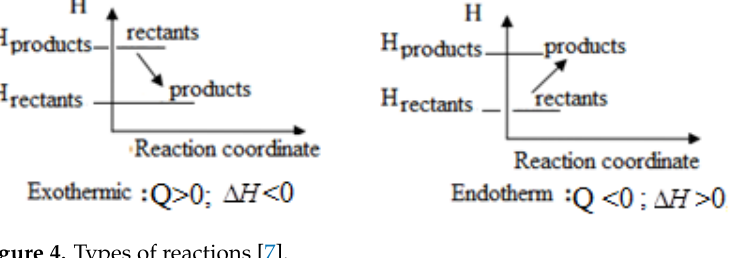
Figure 4. Types of reactions [7].